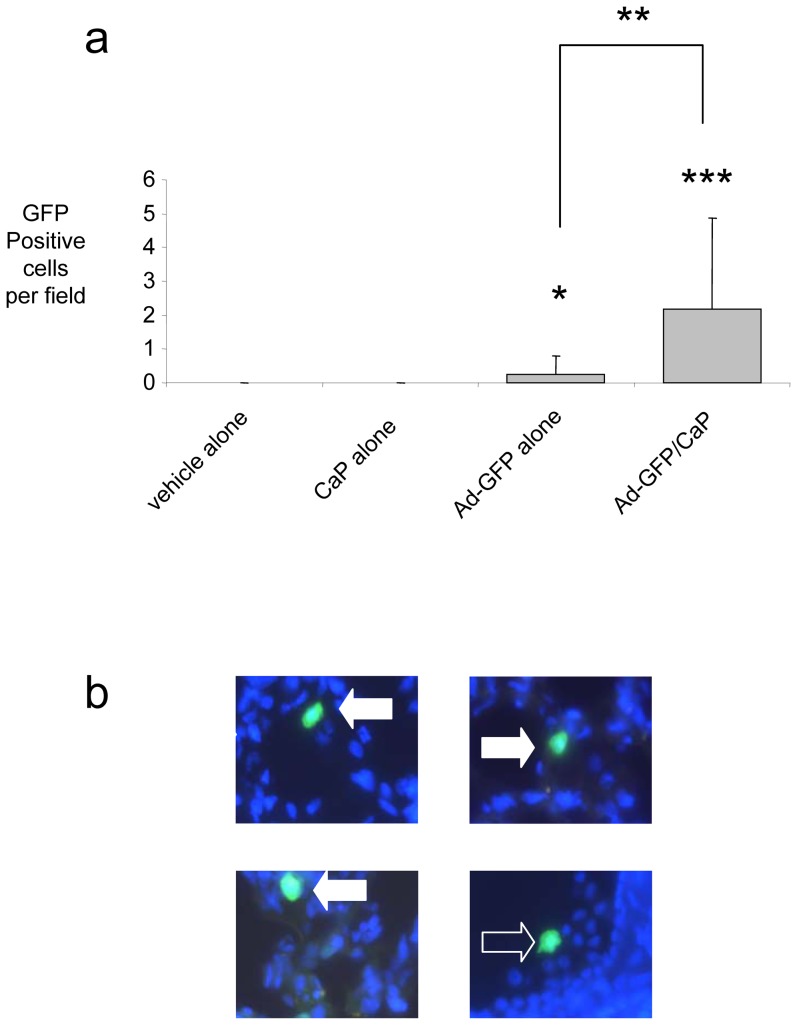
Incorporation of adenovirus into calcium phosphate precipitate increases the infection efficiency of alveolar macrophages and pulmonary respiratory epithelium in vivo.Cryo-sections were prepared from lung tissue 48 hours after instillation of vehicle, vehicle and calcium phosphate, 1×108 pfu Ad-GFP in PBS or 1×108 pfu Ad-GFP after pre-incubation with calcium phosphate. 24 random fields were counted at high power using UV light and the number of GFP+ve cells recorded. (a) – The number of GFP+ve cells is represented here as mean with error bars indicating standard deviation. *, ** and *** indicate P<0.05, P<0.005 and P<0.0005 respectively either comparing values to relevant control (i.e. vehicle alone or vehicle with calcium phosphate) or comparing virus treatment with and without calcium phosphate (indicated by a bar). Significance was calculated by non-paired T Test. (b) – Representative fields from the Ad-GFP/calcium phosphate segment showing infection of Type II epithelial cells (filled arrows) and an alveolar macrophage in an airway (open arrow). Counterstaining of nuclei is with DAPI.